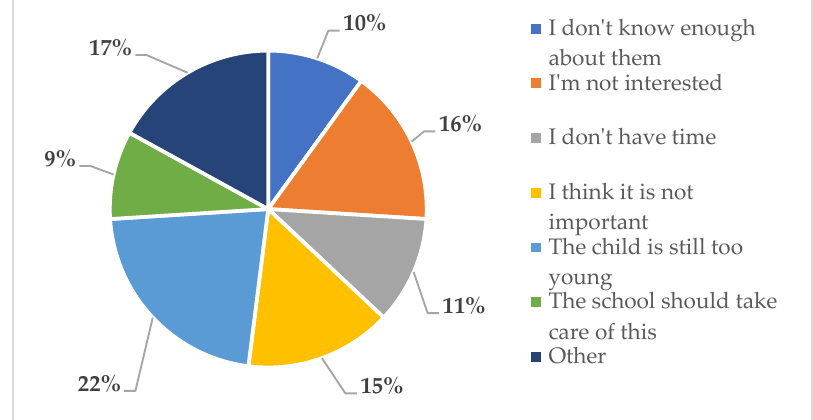
Figure 1. Why do you not include your child in conversations about food sustainability?